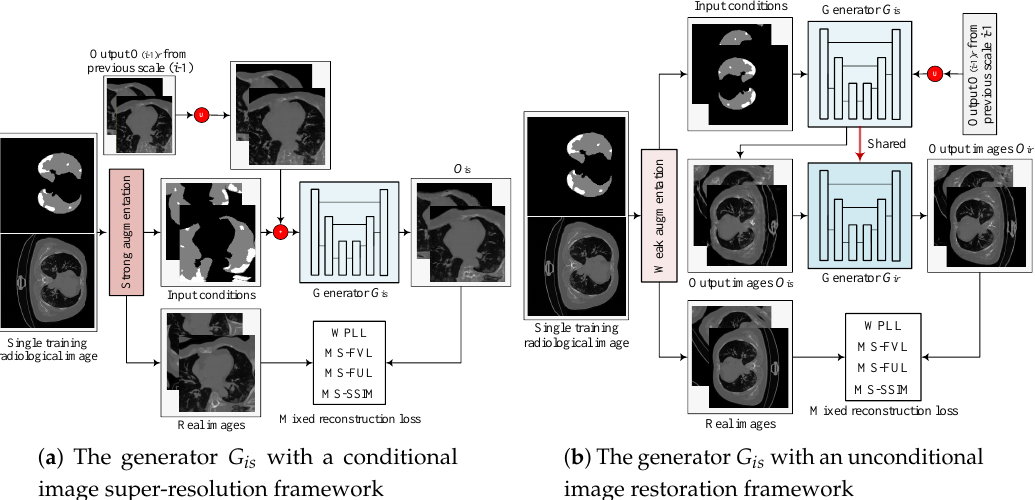
Figure 5. Illustration of the architecture of proposed two-stage GAN at the i-th image scale. The notation U represents an upsampling operation. The white and gray in the condition masks represent the infected regions and lungs,